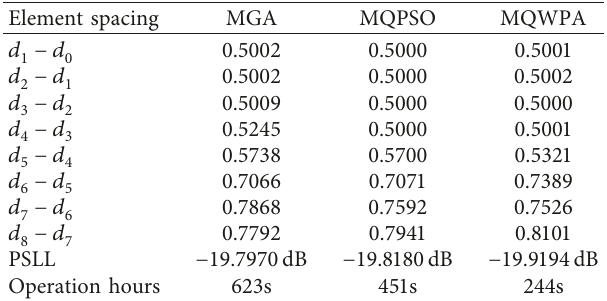
Table 1: Comparison of the best results of three algorithms for optimizing example 1 (unit: λ ).